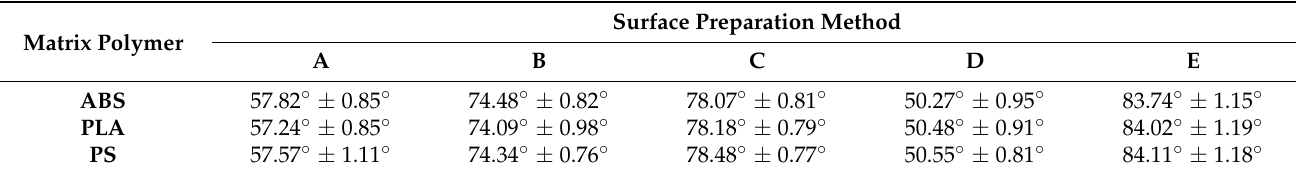
Table 3. Average contact angle measured values for SnBiAg soldering alloy and reflow soldering technique. Matrix